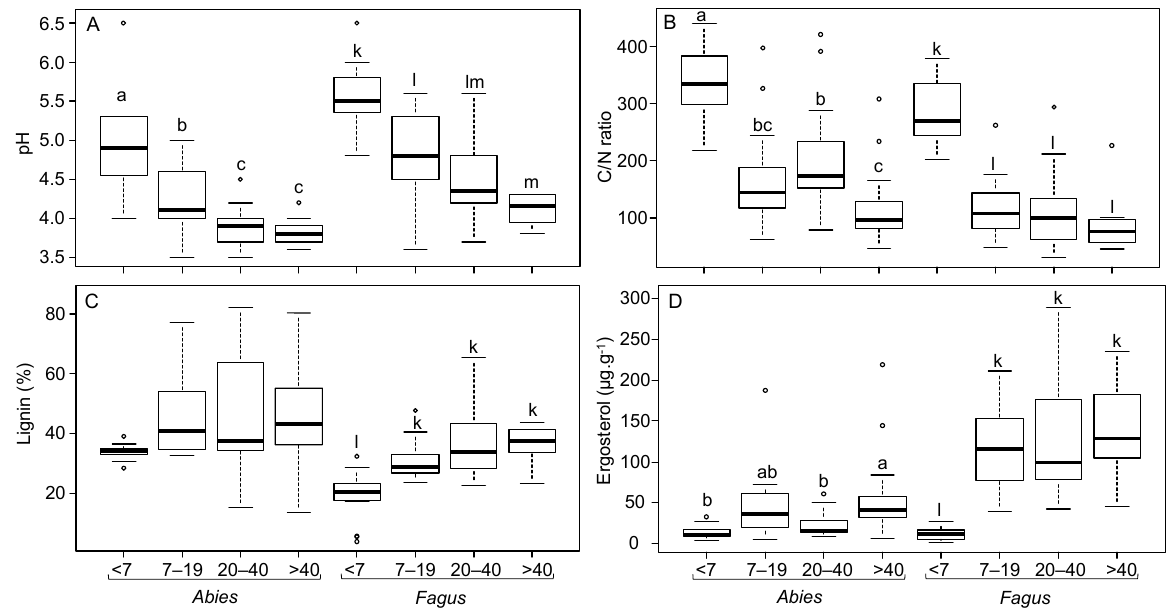
Figure 1. Chemistry of the coarse woody debris of Abies alba and Fagus sylvatica in the Salajka natural forest. ( A ) pH, ( B ) carbon to nitrogen (C/N) ratio, ( C ) percentage of lignin, and ( D ) ergosterol content. Different lowercase letters (designated a–m in the panels) indicate significant differences between decay classes according to Tukey-Kramer HSD tests performed for each tree species independently ( p < 0.05). Gray Dots: outlier points.